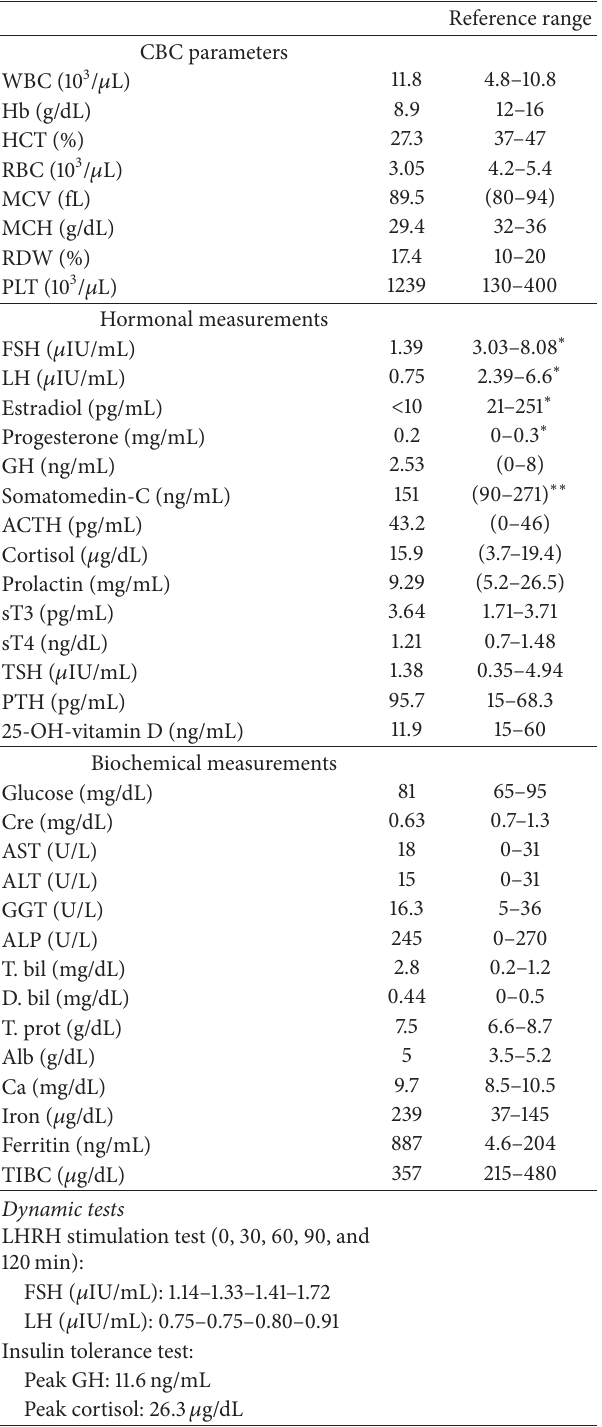
Table 1: Laboratory results of the